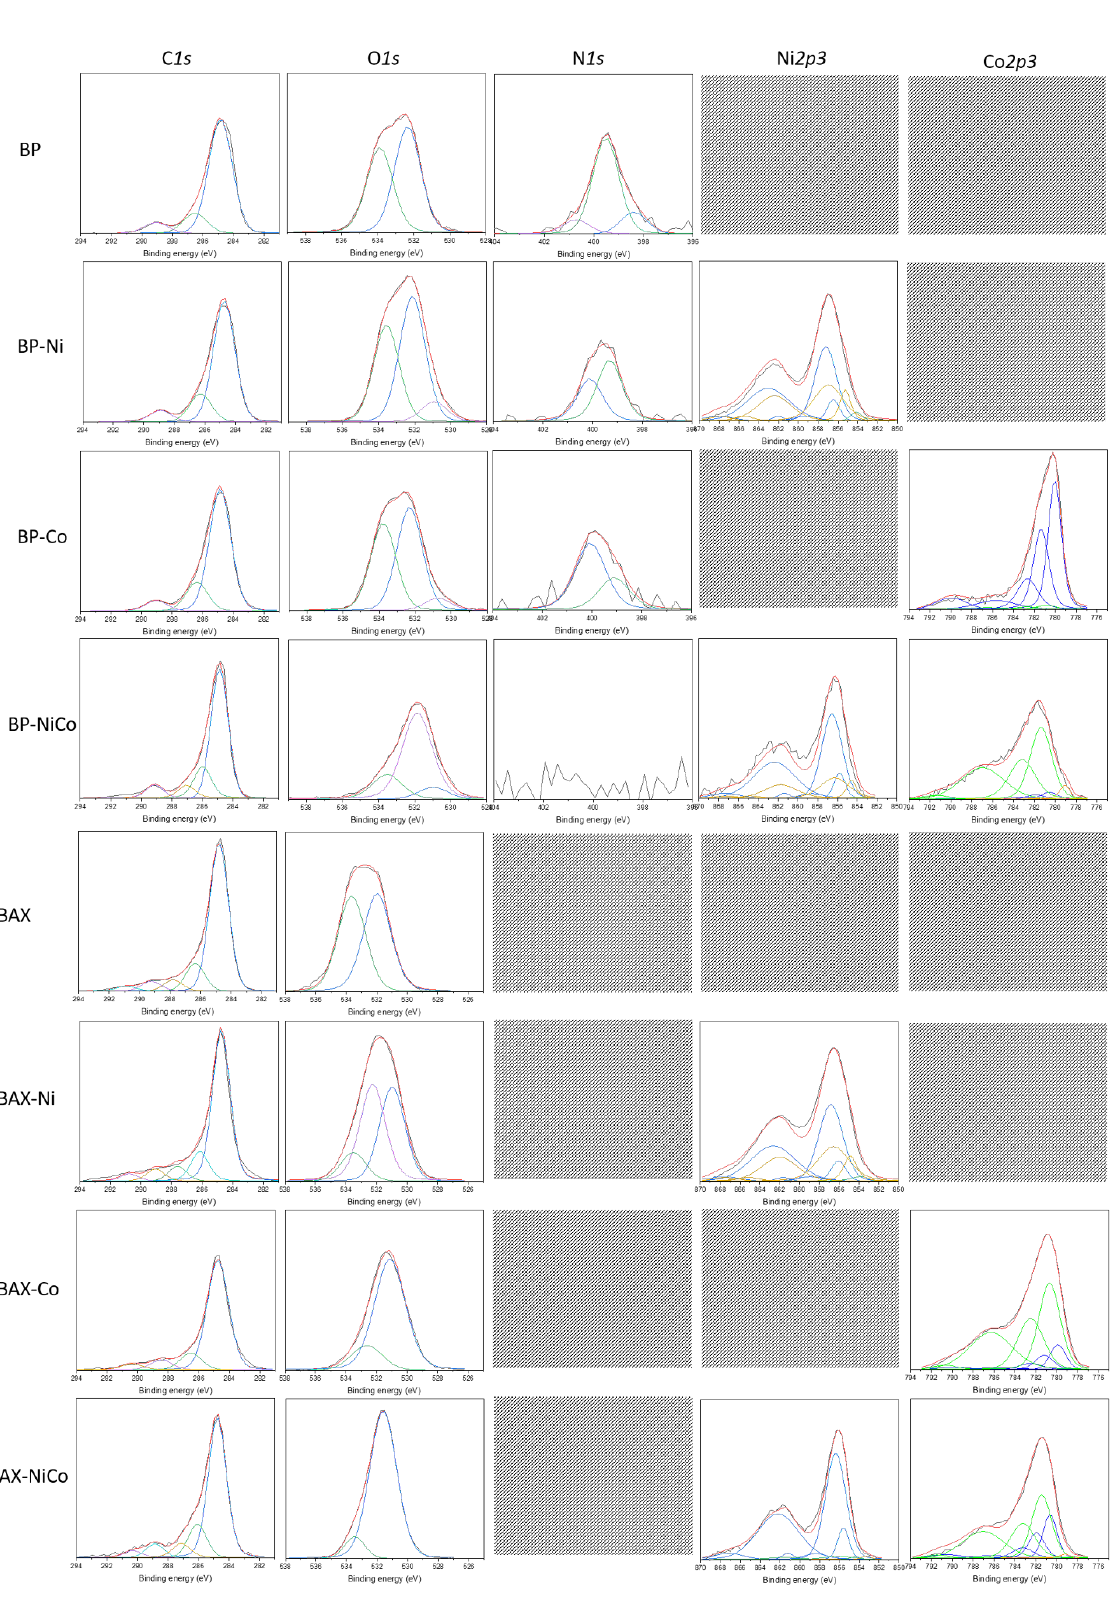
Figure 8. Deconvoluted C 1s, O 1s, N 1s, Co 2p and Ni 2p core energy level spectra (the lines of different colors are used for better visibility of the spectra components)